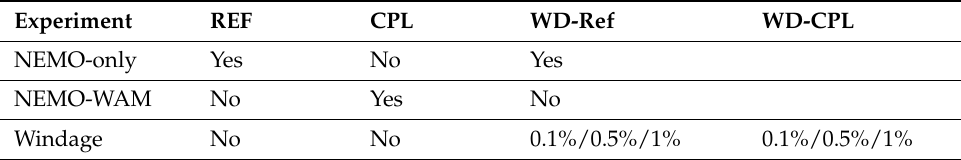
Table 1. List of